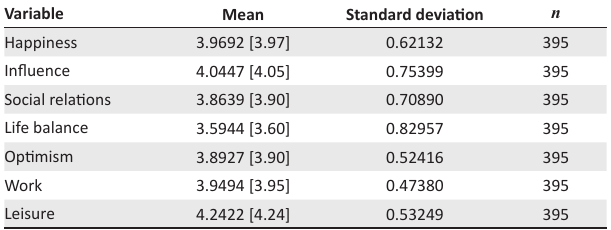
TABLE 3: Analysis of